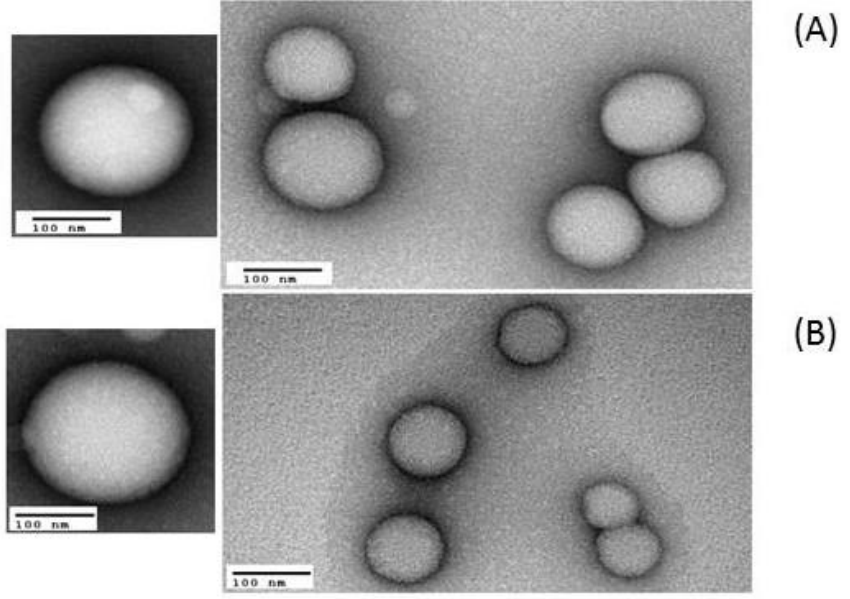
Figure 6. Representative TEM images of PLGA NPs containing ( A ) LNA1 and ( B ) LNA2 stained with UAR (Uranyl Acetate Replacement Stain).